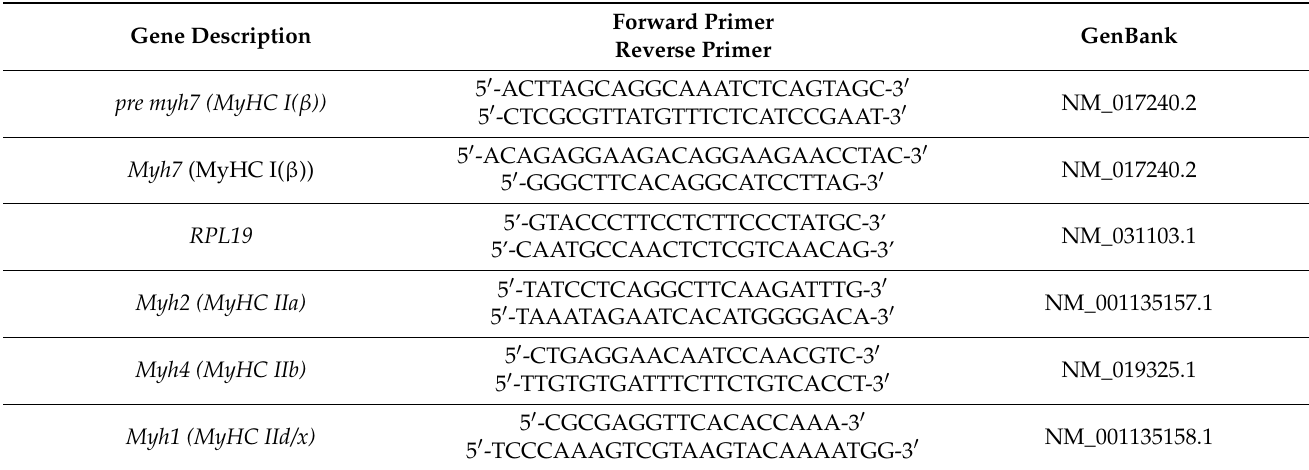
Table 1. Primers used for RT-PCR